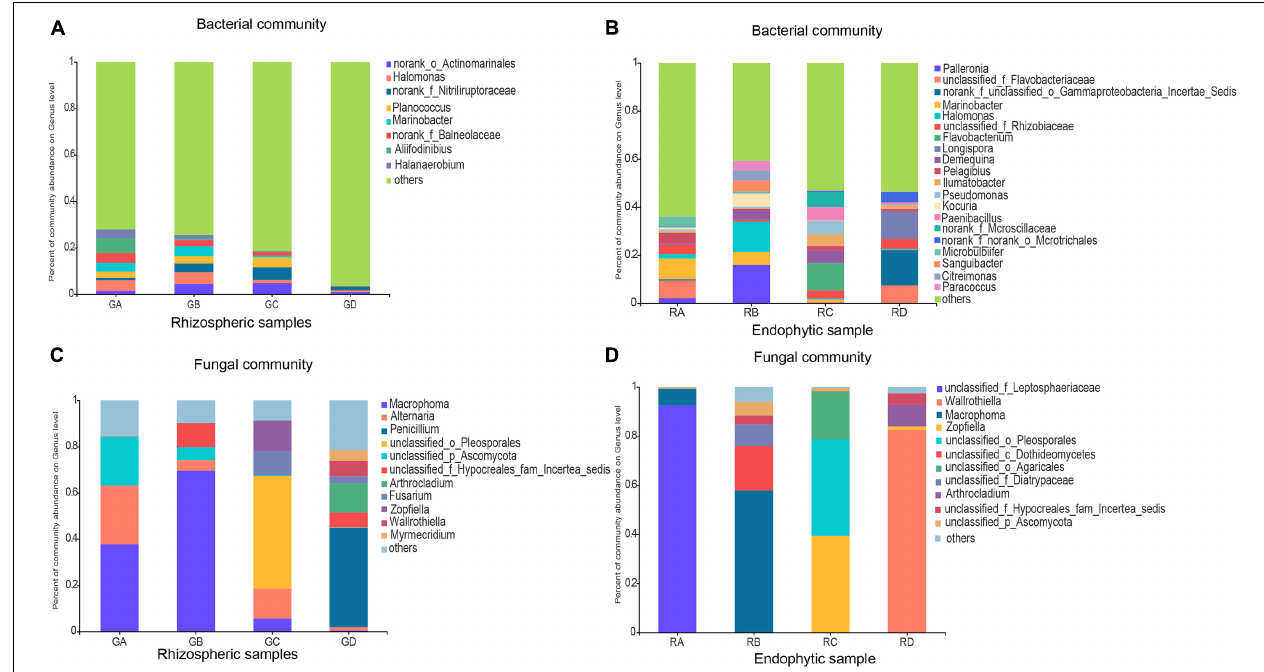
FIGURE 1 | Effects of rhizosphere soil and root endophytic samples on the community composition at the genus level of Bacteria and Fungi in the Ejinur Salt Lake. Genus with relative abundance less than 4% were defined as others. (A) Bacterial rhizospheric samples, (B) bacterial endophytic samples, (C) fungal rhizospheric samples, and (D) fungal endophytic samples. Salicornia europaea (A) , Suaeda salsa (B) , Phragmites communis (C) , and Achnatherum splendens (D)